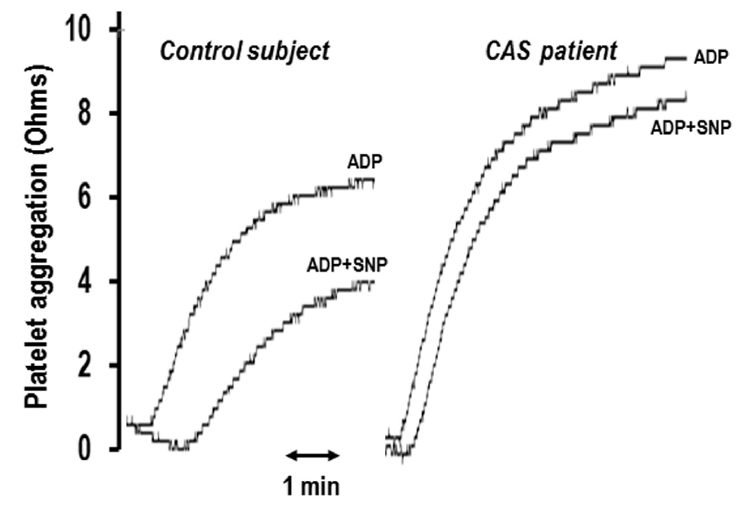
Figure 2. Representative aggregation tracings displaying both an increased platelet aggregation response to ADP (2.5 μ M) and a diminished inhibitory effect of sodium nitroprusside (SNP, 10 μ M) in a coronary artery spasm (CAS) patient (inhibition of 9%) comparative to control subject (inhibition of 33%). Modified with permission from Reference [10].